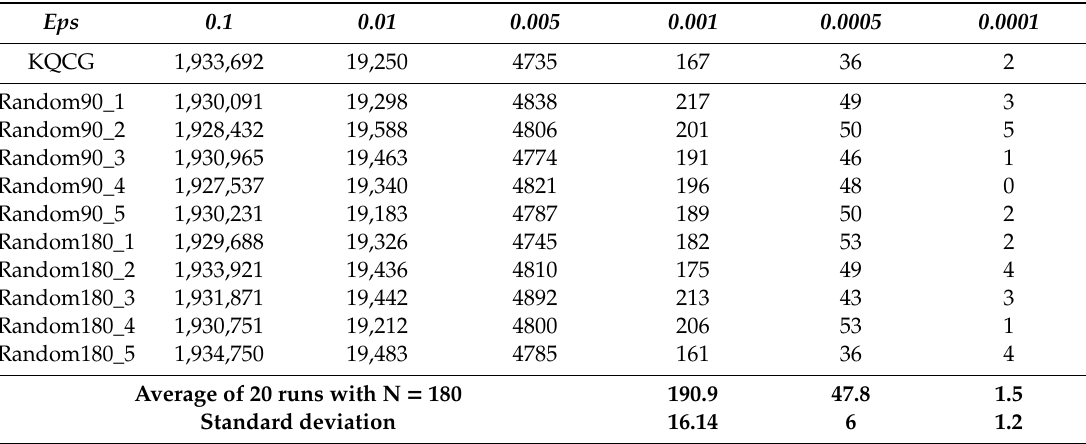
Table 24. Number of opposite pairs for selected angular accuracy values eps in the KQCG catalog and in several random catalogs with the same number of objects and the same angular distribution on the celestial